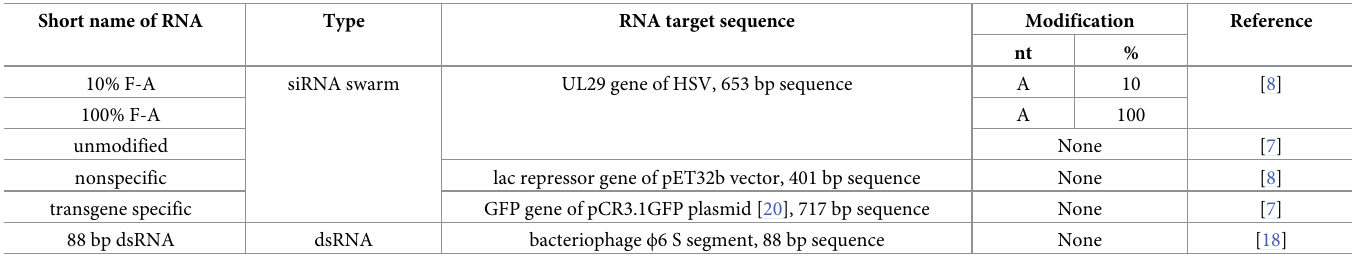
Table 1. dsRNAs used in this